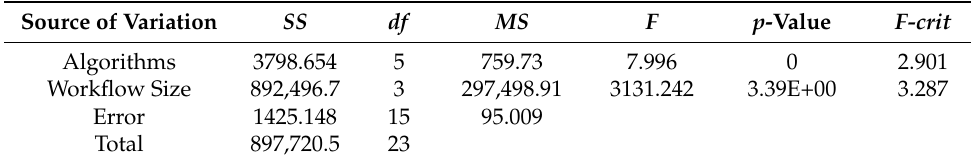
Table 7. Two way ANOVA descriptive results for CyberShake Workflow.